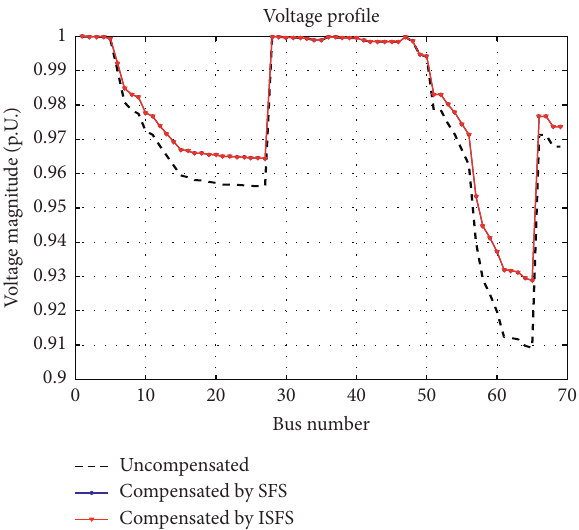
Figure 11: Bus voltage profile of 69-bus network with 100% loading in scenario